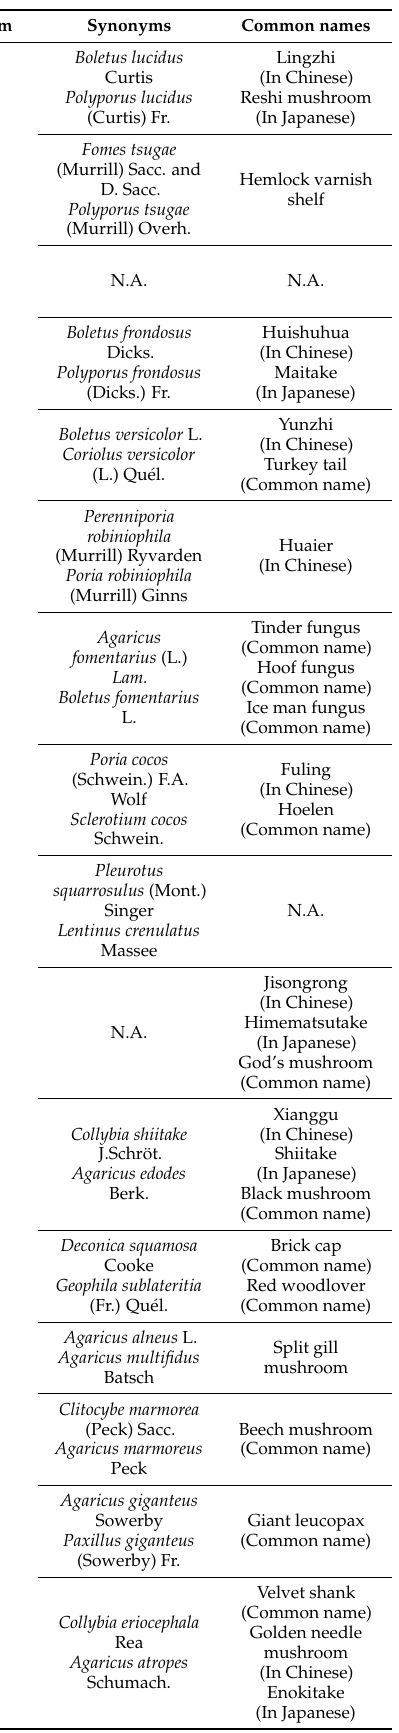
Table 1. Scientific classification and Common name of mycomedicines discussed in this